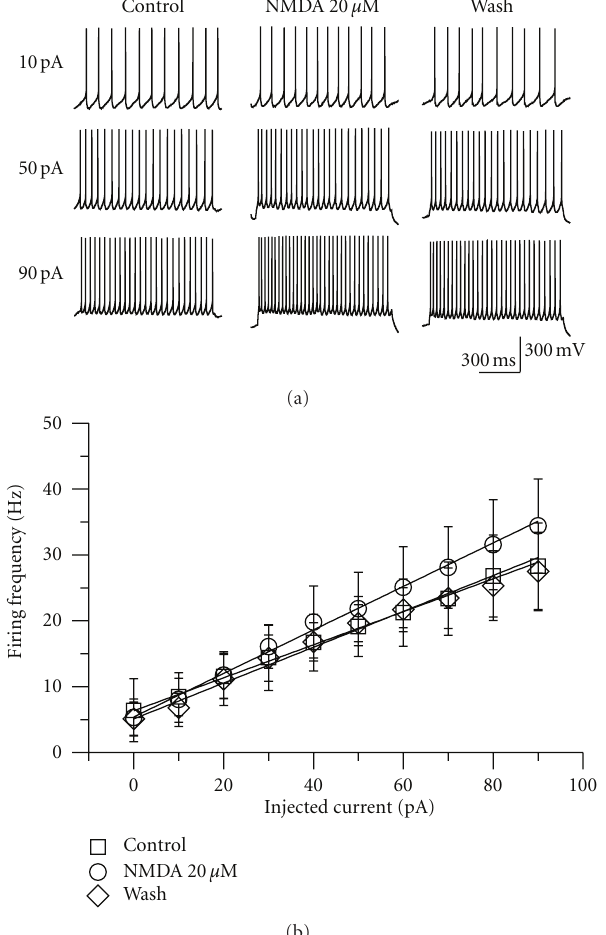
Figure 1: (a) Traces of action potentials in response to 1 s current steps of 10, 50, and 90 pA (top to bottom). The average frequencies were 8.98, 18.54, and 27.05 Hz, respectively, before NMDA application (left column); NMDA increased the frequency and the average frequencies were 8.72, 23.62, and 33.34 Hz after application of NMDA (20 μ M) for 8min (middle column); the e ff ects were reversed after wash for 15 min (right column). (b) The slope of the f-I relationships was changed after 20 μ M NMDA application when depolarizing current steps from 0 to 90 pA. The slopes were 246 . 92 ± 28 . 00, 325 . 49 ± 73 . 34, and 253 . 03 ± 48 . 54 Hz/nA for the control, NMDA treatment, and wash, respectively ( P < 0 . 05, n = 11). 20 μ M NMDA increased the gain of RA projection neurons. The average in control is shown as open squares, group in NMDA is shown as open circles, and the group after wash is shown as open diamonds.